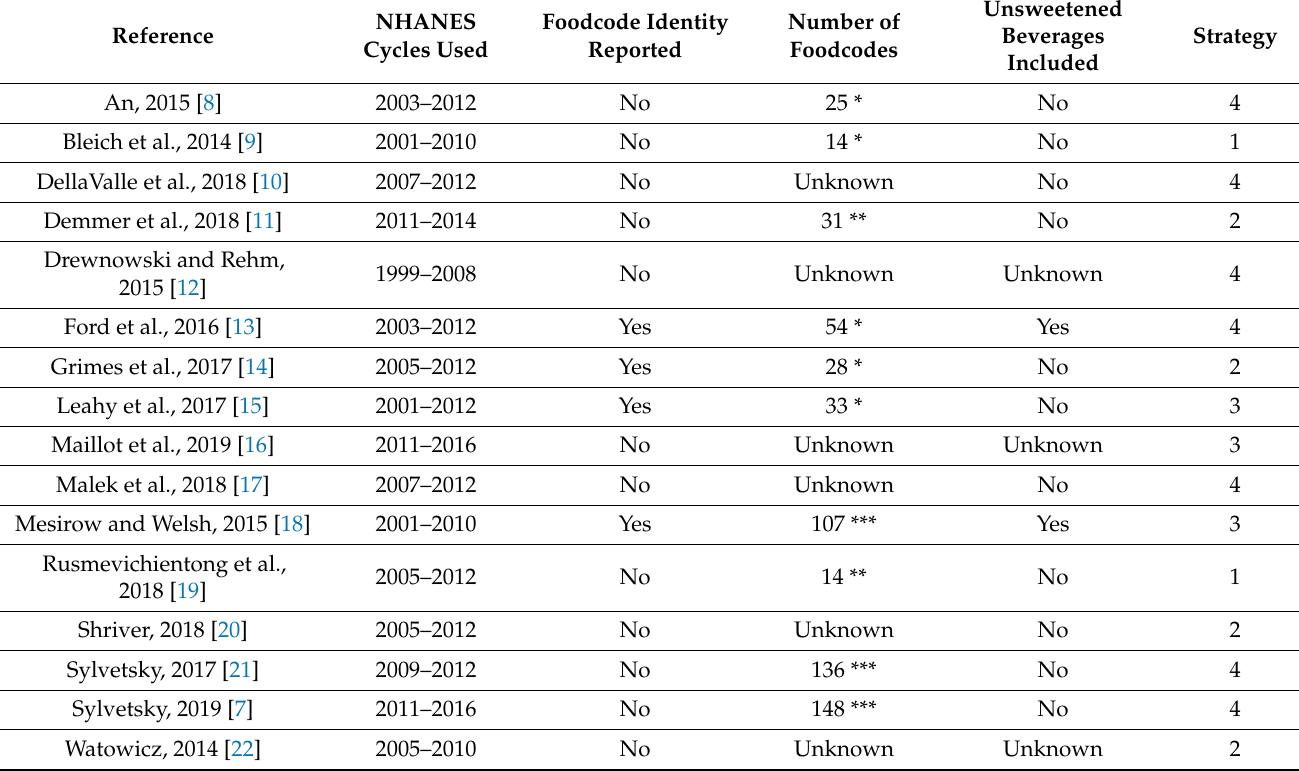
Table 1. Characteristics of LCSB/Diet/Low-Calorie Beverage Groups from Selected